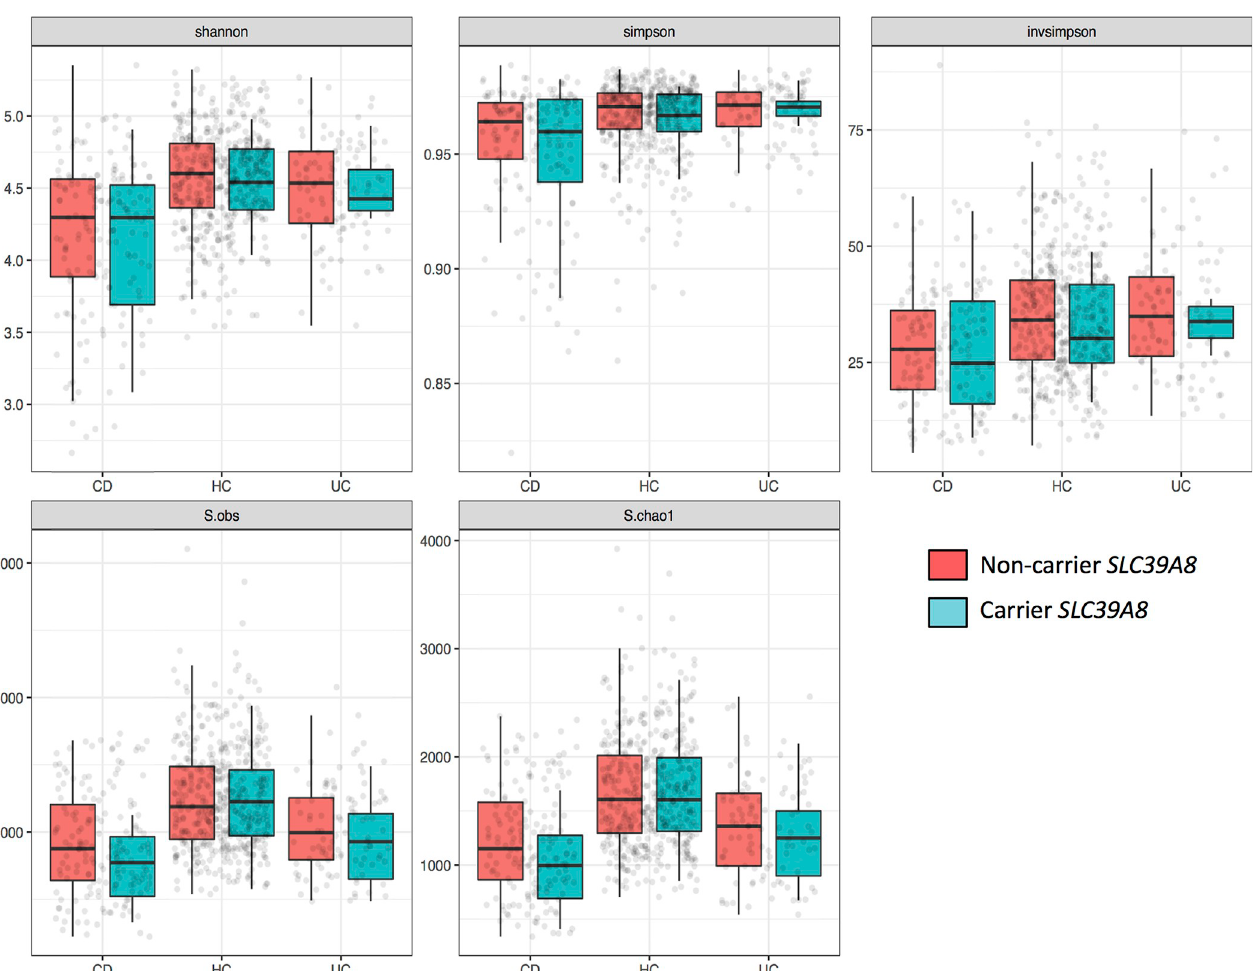
Fig 2. Alpha diversity within CD, UC and HC by using five methods. Alpha diversity calculated by five different methods, from left to right: Shannon Index, Simpson, inversed Simpson, observed species and Chao1. Carrier status does not show statistically significant differences in non-carriers and carriers of the SLC39A8 missense variants in Crohn’s disease, healthy controls and ulcerative colitis.